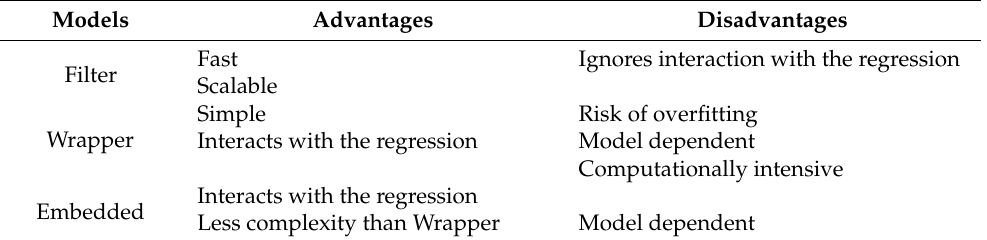
Table 4. Comparison of advantages and disadvantages of three types of feature selection.